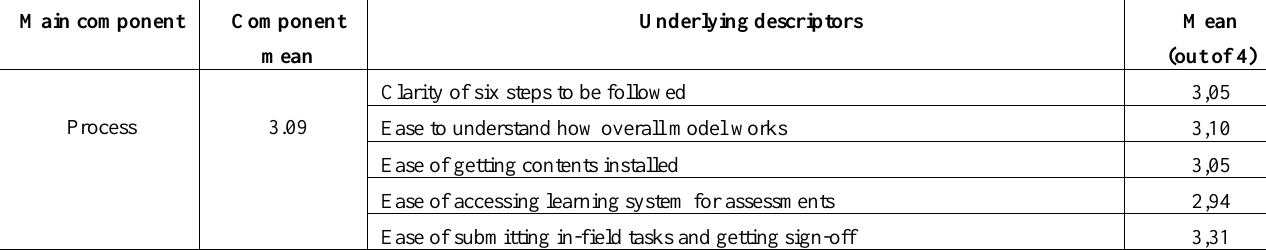
Table 3: Rating of process of ID model